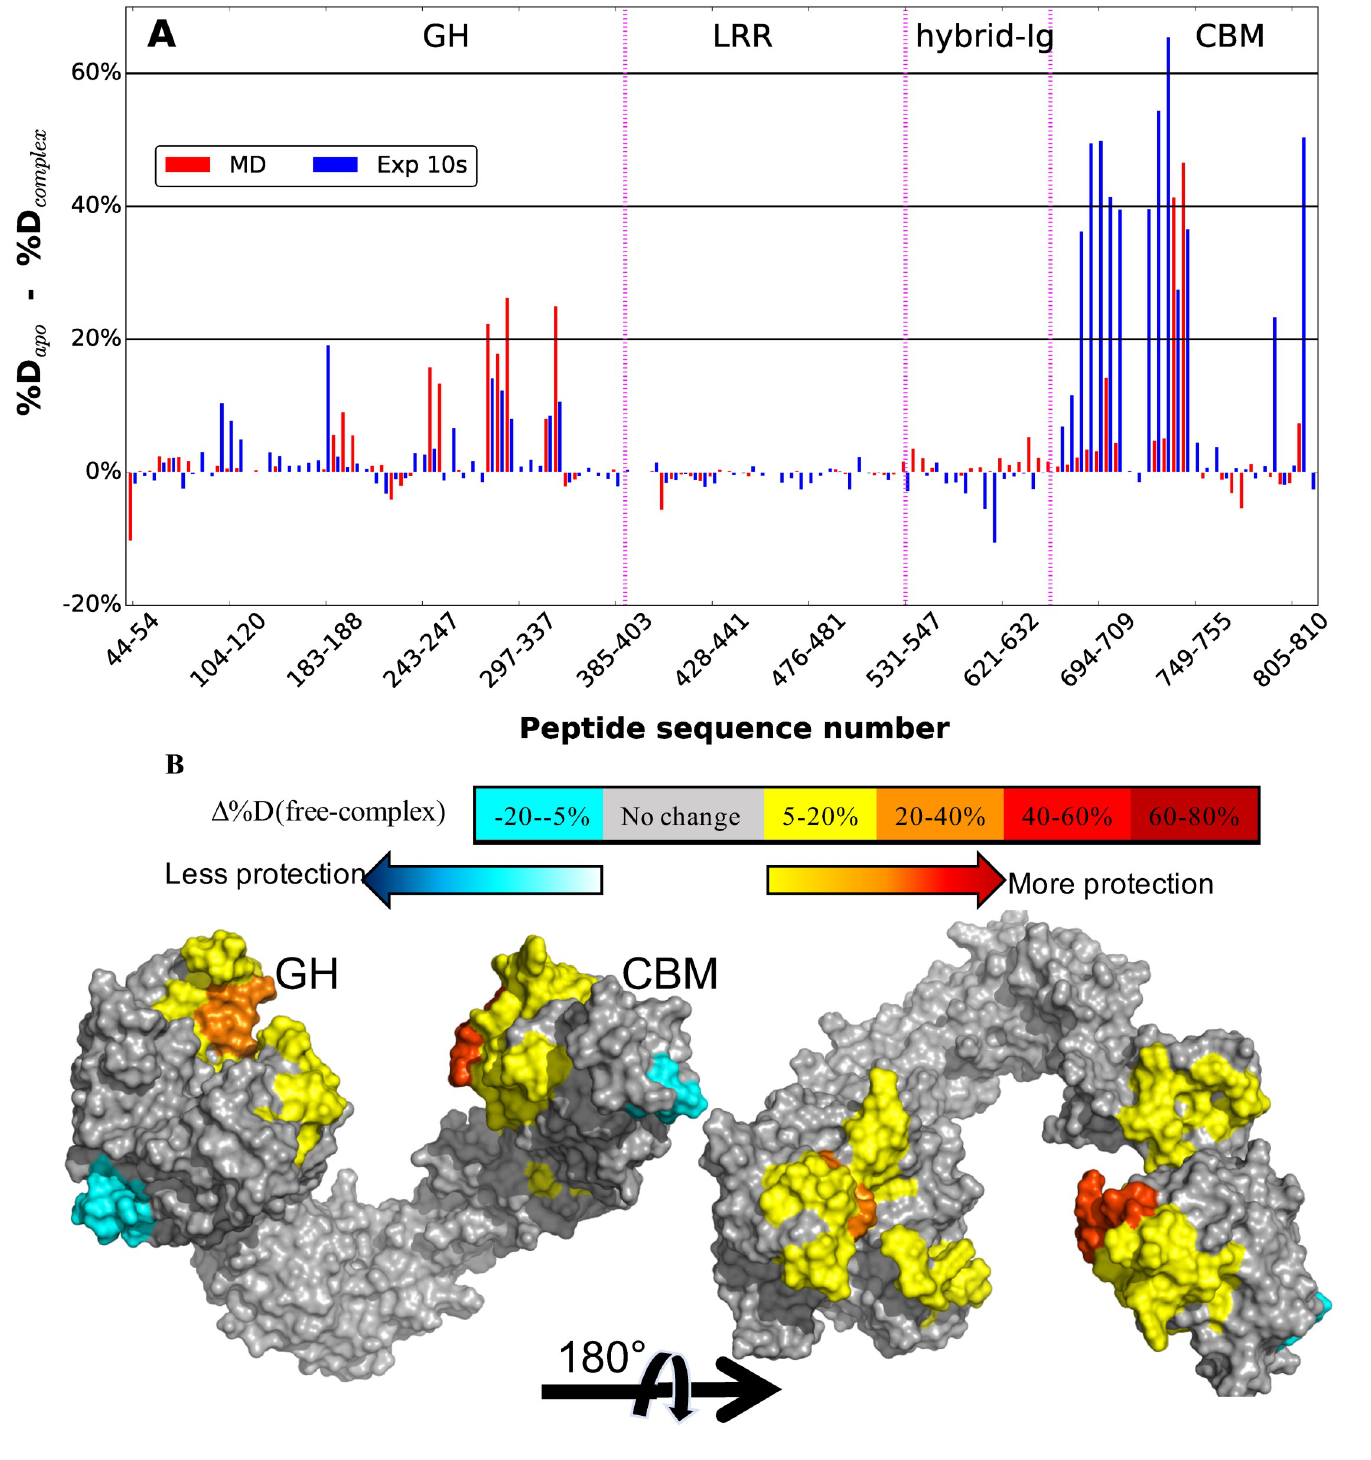
Fig 9. A) Percent difference in hydrogen-deuterium exchange from experimental studies [25] and from multi-microsecond MD simulations for the diglycosylated species averaged over all the models. Experimental differences in percent deuteration between peptides from EndoS2 in the apo and IgG1-complexed diglycosylated state after 10s are plotted as blue bars and the average percent difference from the apo EndoS2 and Fc-glycan-EndoS2 complex simulations as red bars. The different domains of Endos2 are labelled across the top of the figure and separated by purple dashed lines as follows: Glycoside hydrolase (GH), leucine-rich repeat (LRR), hybrid-Ig, and